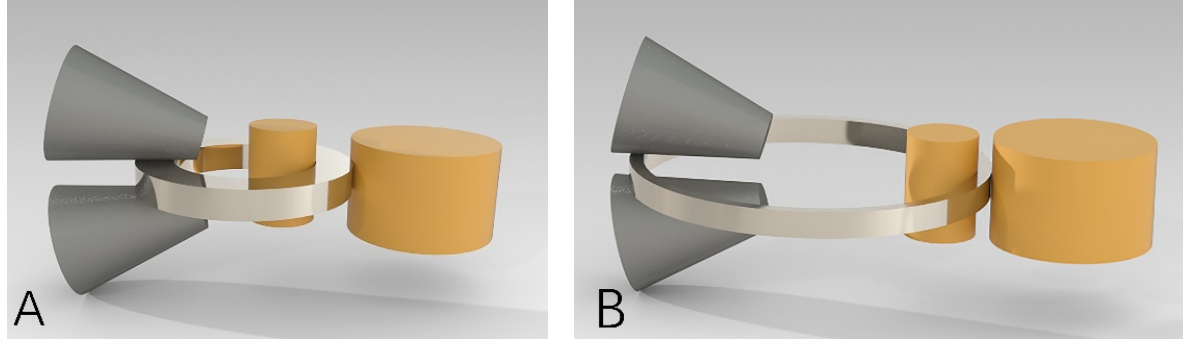
Figure 4. Schematic diagram of the rolling model: ( A ) before rolling and ( B ) after rolling.